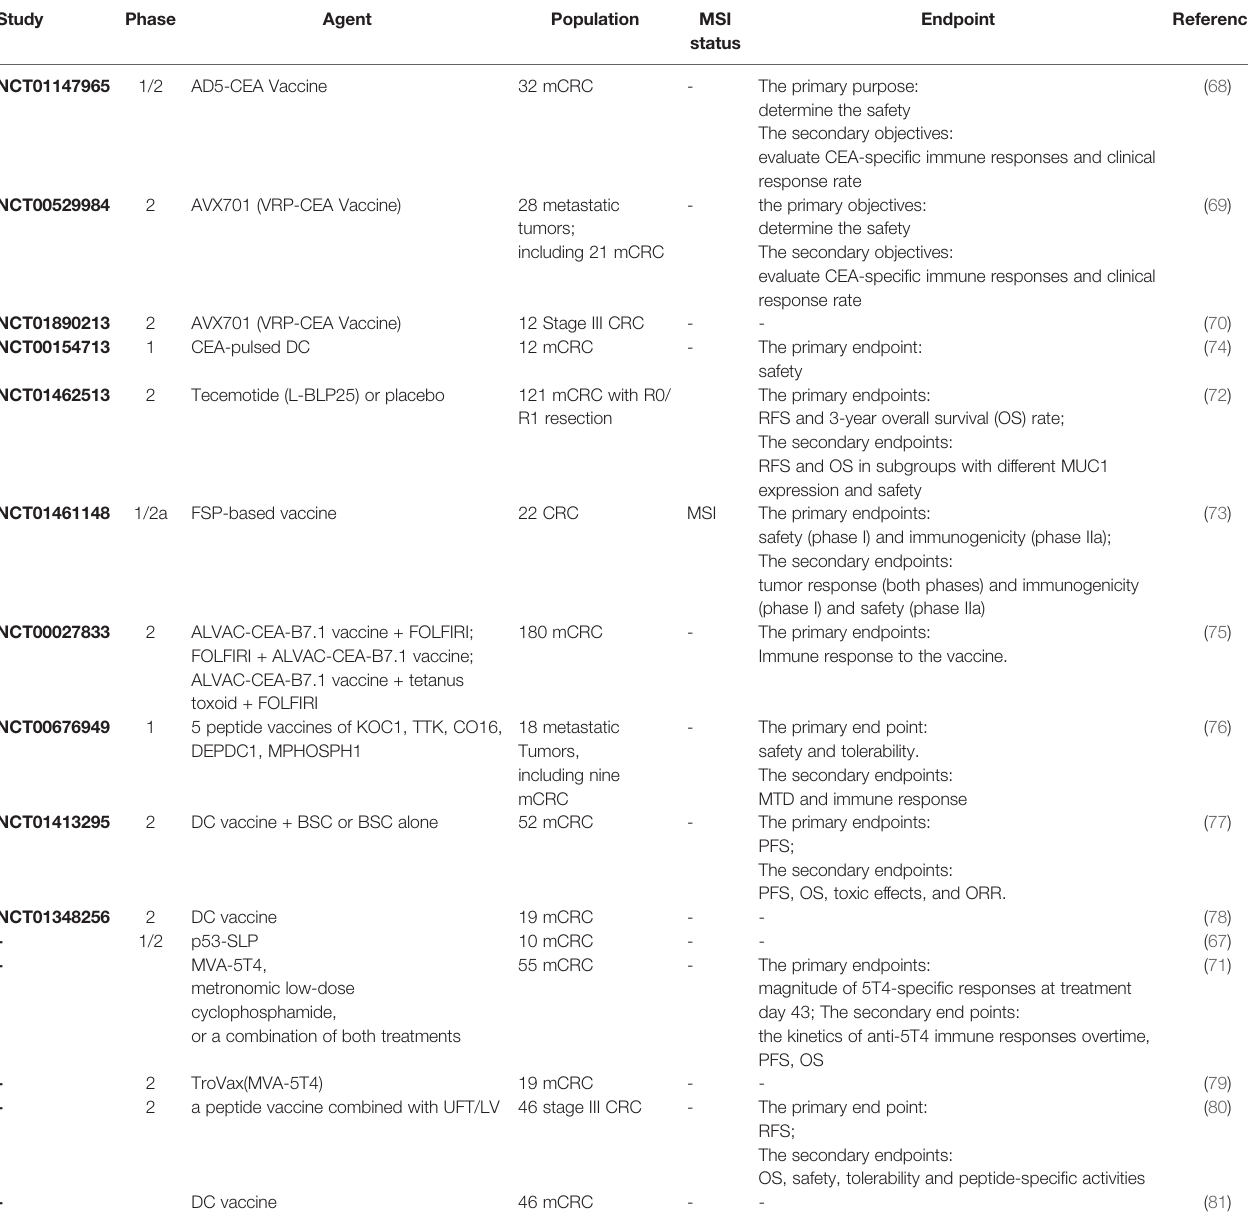
TABLE 2 | Summary of Vaccine Treatment for